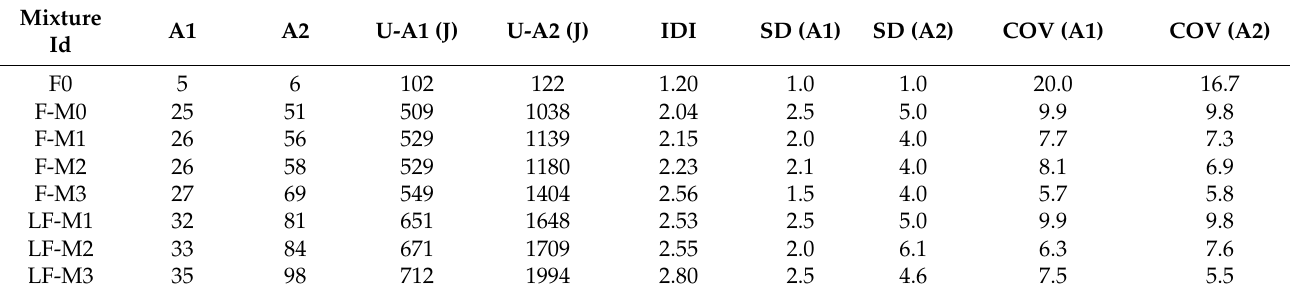
Table 2. Impact strength test results.